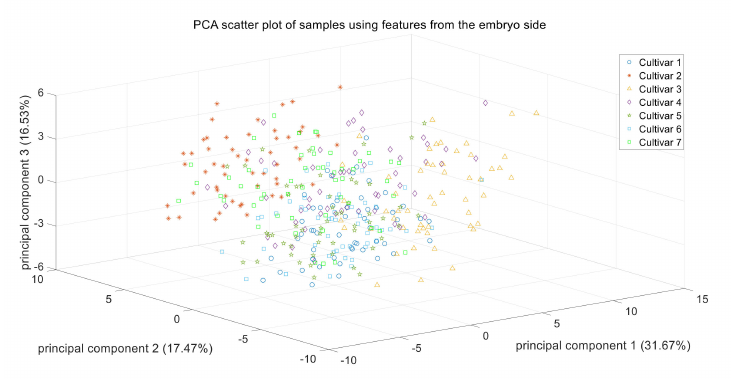
Figure 7. Principal component analysis (PCA) scatter plot of samples using features from the embryo side.